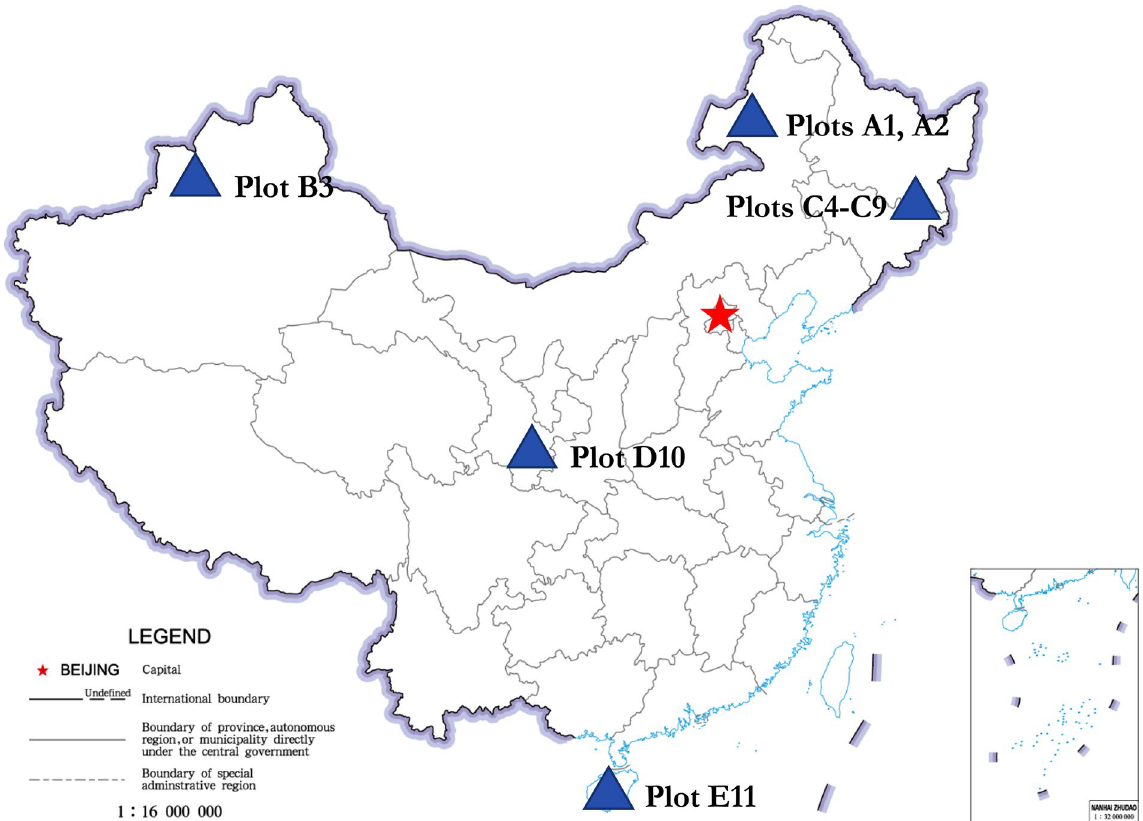
Figure 1. Location of the sample plots in China (The Chinese Map was generated by the Standard map online service, URL link: Plots A1 and A2, located in the southern part of a sandy area in Honghuaerji within the Inner Mongolian Province, belong to the transitional zone between the eastern slope of the middle of the Daxingan Mountains and the Inner Mongolian plateau (47° 36 ′ –48° 35 ′ N, 118° 58 ′ –120° 32 ′ E); the location is 700–1100 m above sea level. The zone experiences a mid-temperate, semi-humid, and semiarid continental monsoon climate, with a mean annual temperature of 1.5 °C and average annual precipitation of 344 mm. The main soil type is sand. The forest type is natural pure Pinus sylvestris var. mongolica forest 47 . Plot B3, located in the Xitian Mountain National Nature Reserve in Gongliu County, Xinjiang Province, is part of the Tianshan Mountains (43° 59 ′ –43° 28 ′ N, 87° 12 ′ –87° 50 ′ E) and located 1635 to 1706 m above sea level. The region experiences a temperate continental climate, with mostly cold weather and great seasonal changes in temperature. The mean annual temperature is approximately 5 °C to 7 °C, and the average annual precipitation is 600 to 800 mm. The main soil type is mountain grey cinnamon forest soil, and the forest type is Picea schrenkiana natural forest with very few Betula tianschanica 47 . Plots C4–C9, located on an eastern slope of the Jiaohe Forest Experimental Zone Management Bureau in Jilin Province (43° 51 ′ –44° 05 ′ N, 127° 35 ′ –127° 51 ′ E), is approximately 400 to 500 m above sea level and experience a temperate continental monsoon climate. The region has a mean annual temperature of approximately 3.5 °C and average annual precipitation of 700 to 800 mm. The soil type is dark brown soil with high fertility, and the forest type is mixed broadleaf-conifer that is composed primarily of coniferous trees such as Pinus koraiensis Sieb. et Zucc and Abies holophylla Maxim. and broadleaf trees such as Fraxinus mandshurica Rupr., Juglans mandshurica Maxim., Acer mandshurica Maxim., Carpinus cordata , Tilia mandschurica Rupr. et Maxim., and Quercus mongolica Fisch 47 . Plot D10, located within the Xiaolong Mountains in Gansu Province (33° 30 ′ –34° 49 ′ N, 104° 22 ′ –106° 43 ′